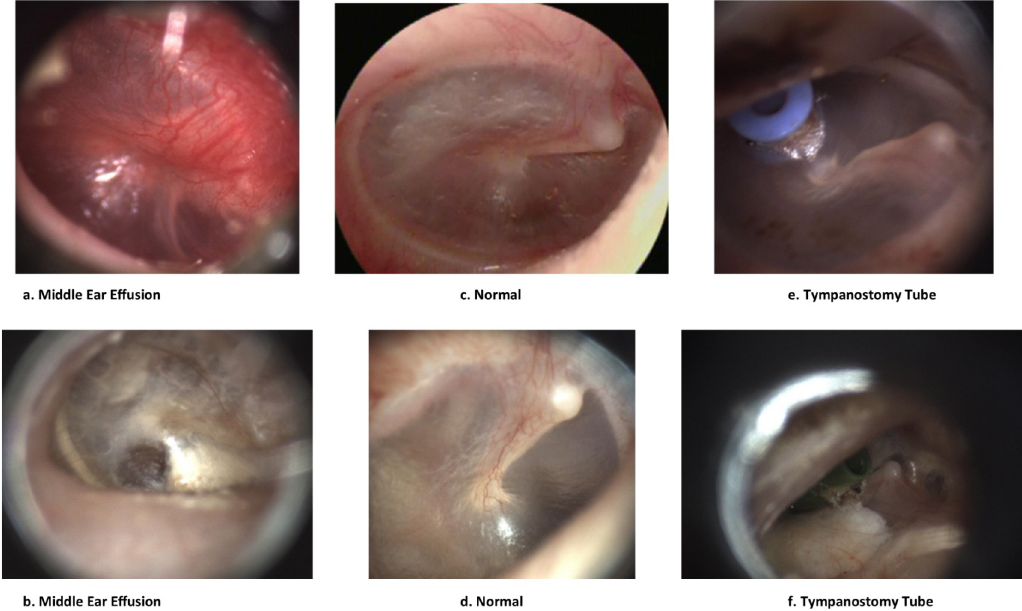
Fig 2. Example images of eardrum abnormalities: a & b- Middle Ear Effusion, c & d- Normal, e & f- Tympanostomy